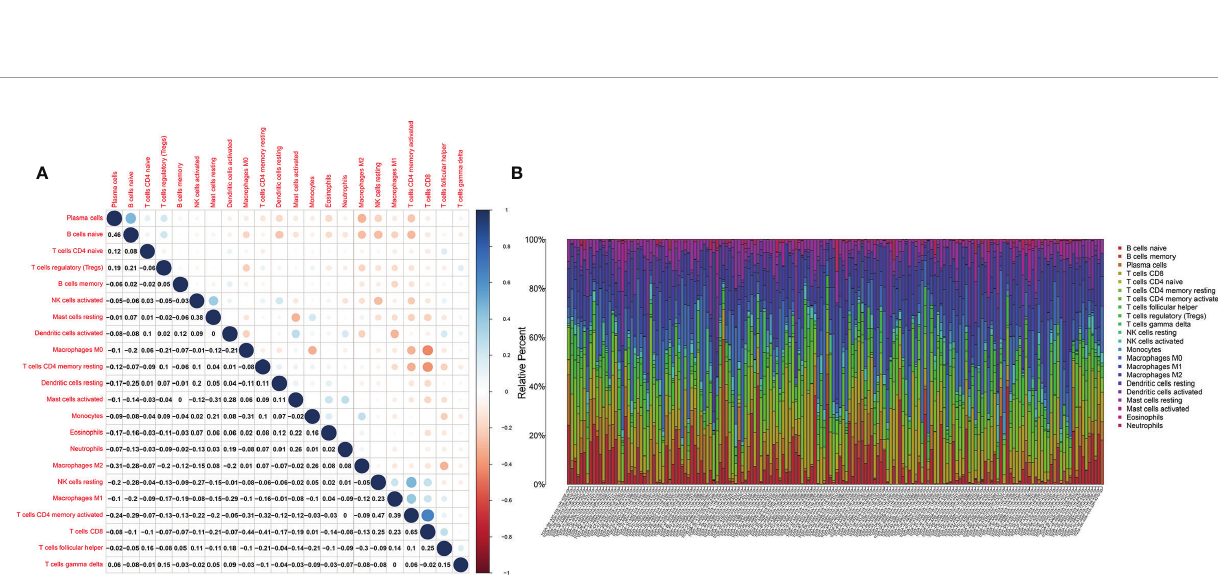
FIGURE 10 | IGF1 and MMP9 were identi fi ed as the hub genes in the signature. (A, B) The expression of MMP9 and FAHD2P1 was signi fi cantly higher in the tumor samples than in the normal samples ( p < 0.01). (C) The expression of IGF1 was signi fi cantly lower in the tumor samples compared with the normal samples ( p < 0.001). (D) The Venn plot showing IGF1 and MMP9 as the common genes between DEGs and stage-correlated genes.